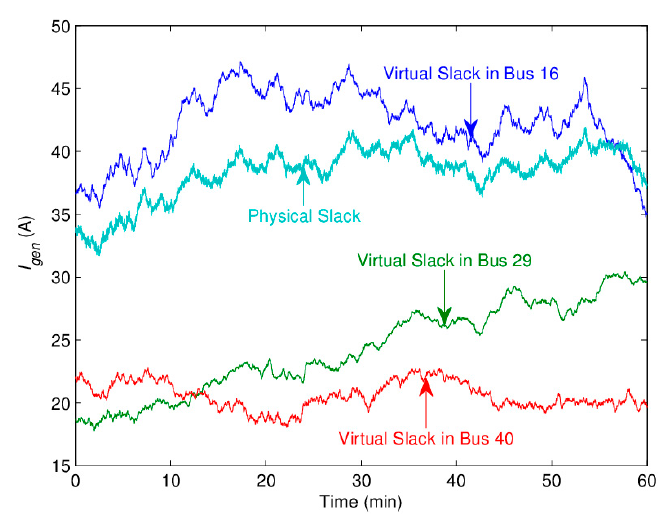
Figure 8. Currents of physical and virtual slack DGs.